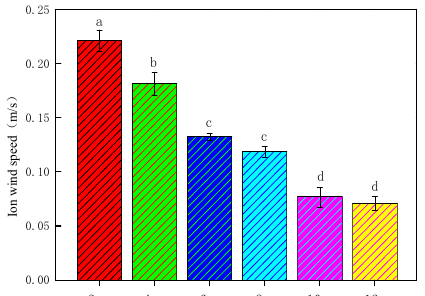
Figure 2. Variation in ionic wind speeds under different needle spacings. Data are shown as the mean ± standard deviation (SD). For each response, means with different lower-case letters are significantly different ( p < 0.05).